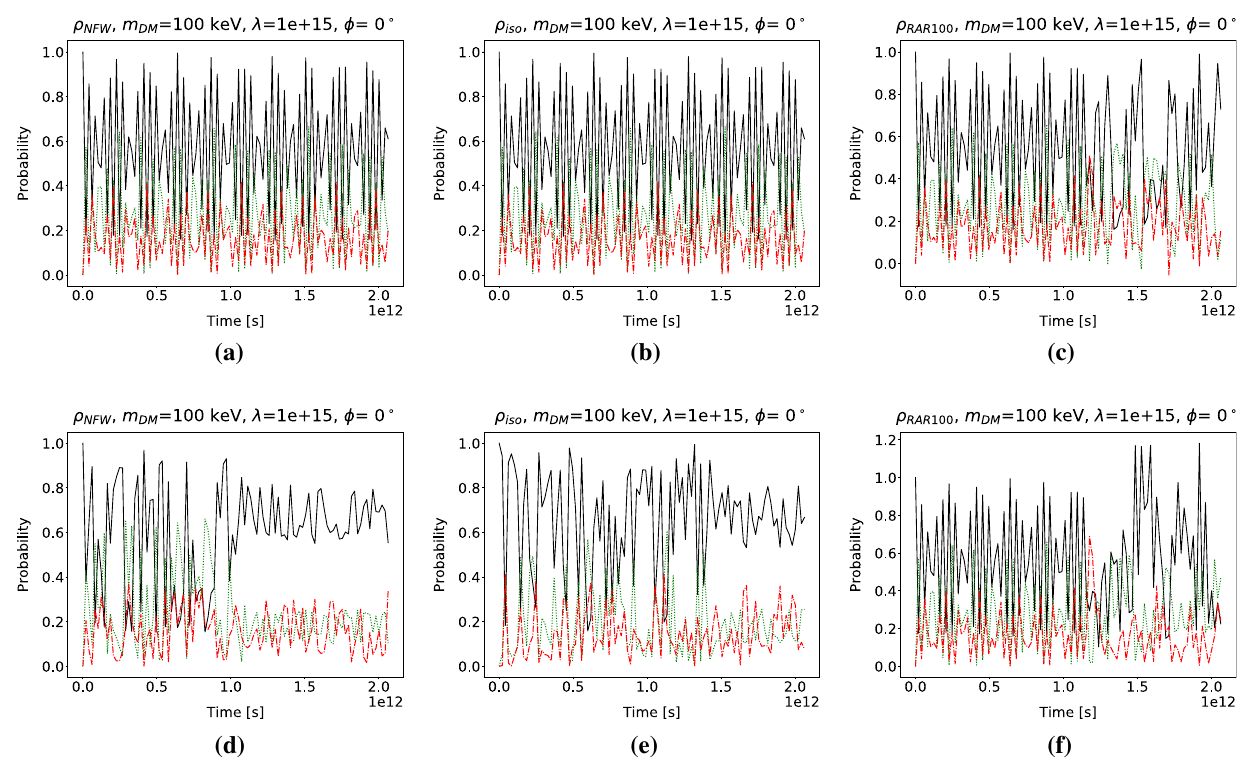
Fig. 5 Survival and disappearance probabilities in presence of DM as a function of time, for a value of the DM mass m DM = 100 keV and for the NFW ( a , d ), isotropic ( b , e ) and RAR ( c , f ) DM density profiles, considering different textures for the matrix Λ (cases a – c correspond to Λ = I 3 x 3 , and cases d – f correspond to Λ 11 = Λ 33 = − 1, Λ ik = 0